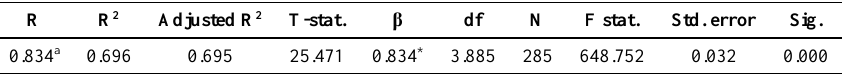
Table 3. Hypothesis two result N=285